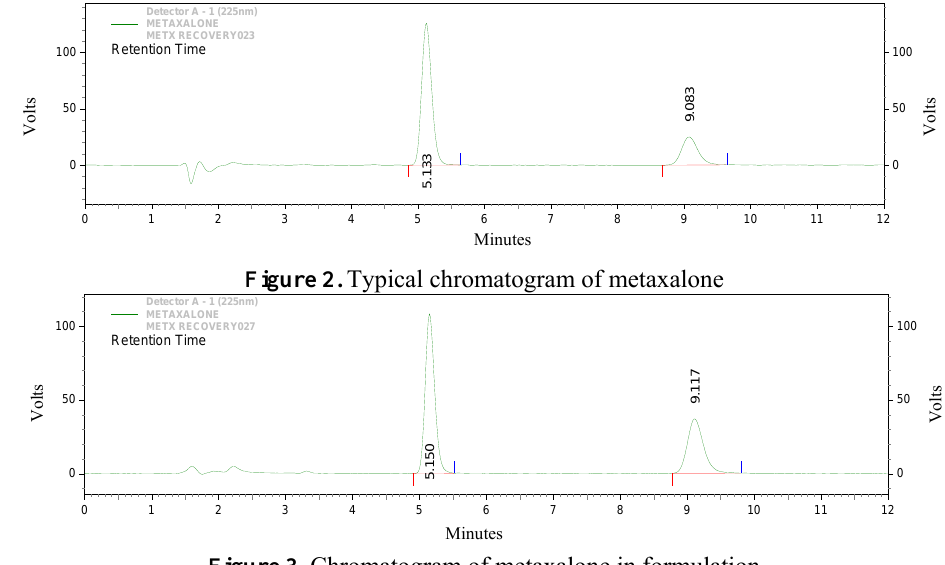
Figure 2. Typical chromatogram of metaxalone